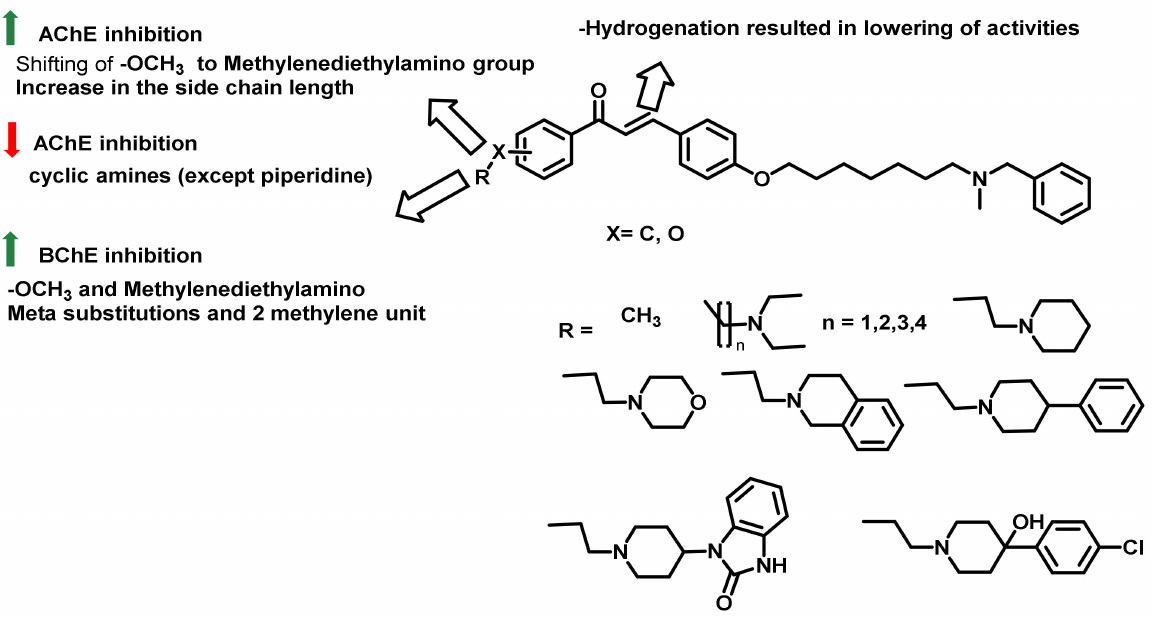
Figure 21. Chalcone derivatives reported by Rampa et